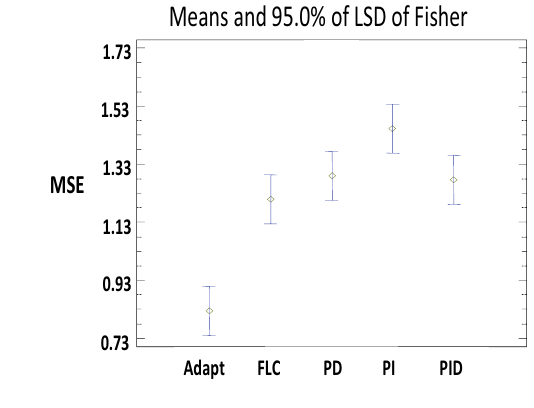
Figure 4. Means of MSE of all used